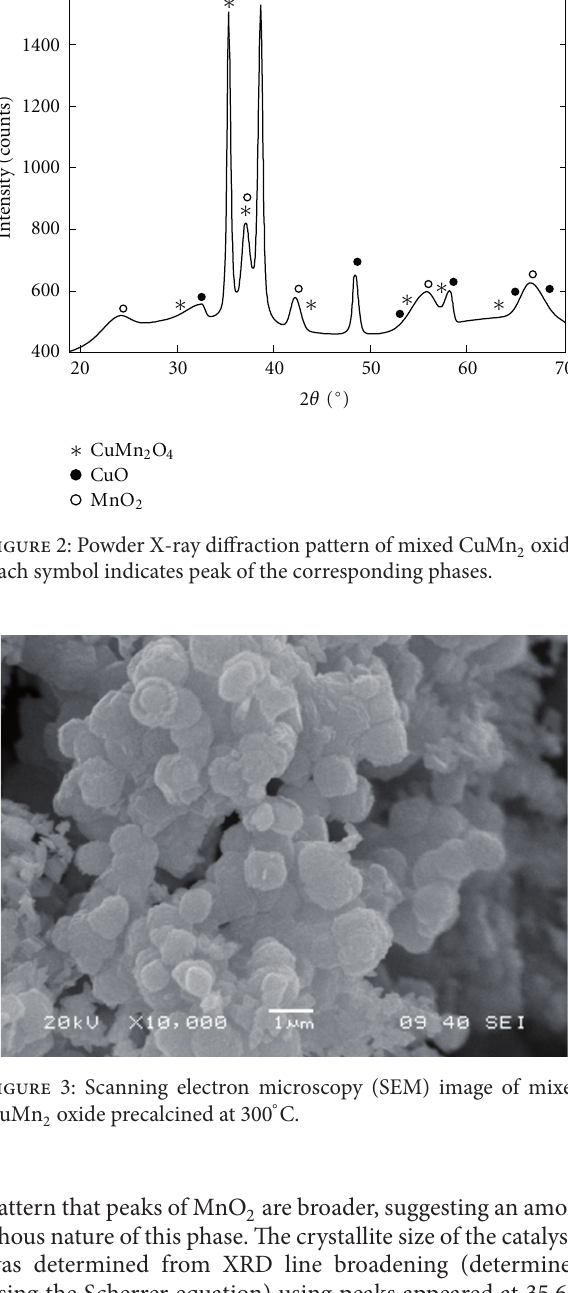
F 3: Scanning electron microscopy (SEM) image of